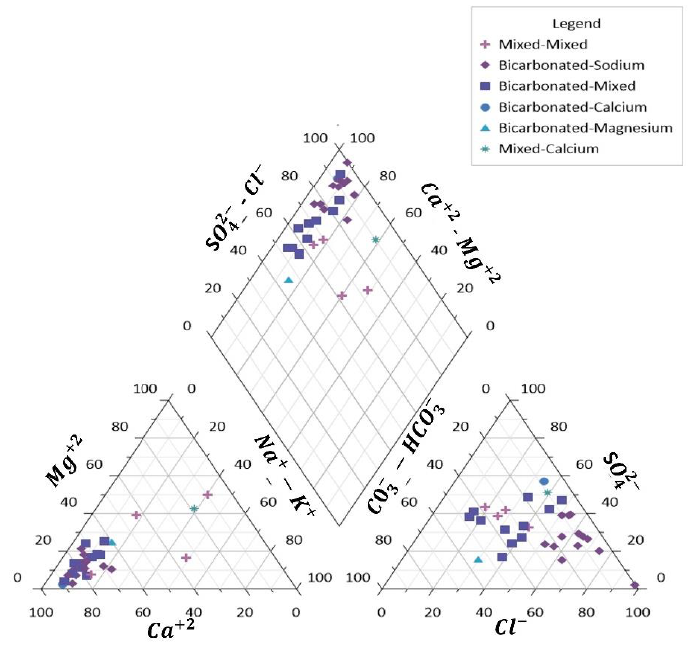
Figure 4. Water families from the Calera aquifer. Table 2. Correlation matrix for physicochemical parameters in water sampled in 2020.